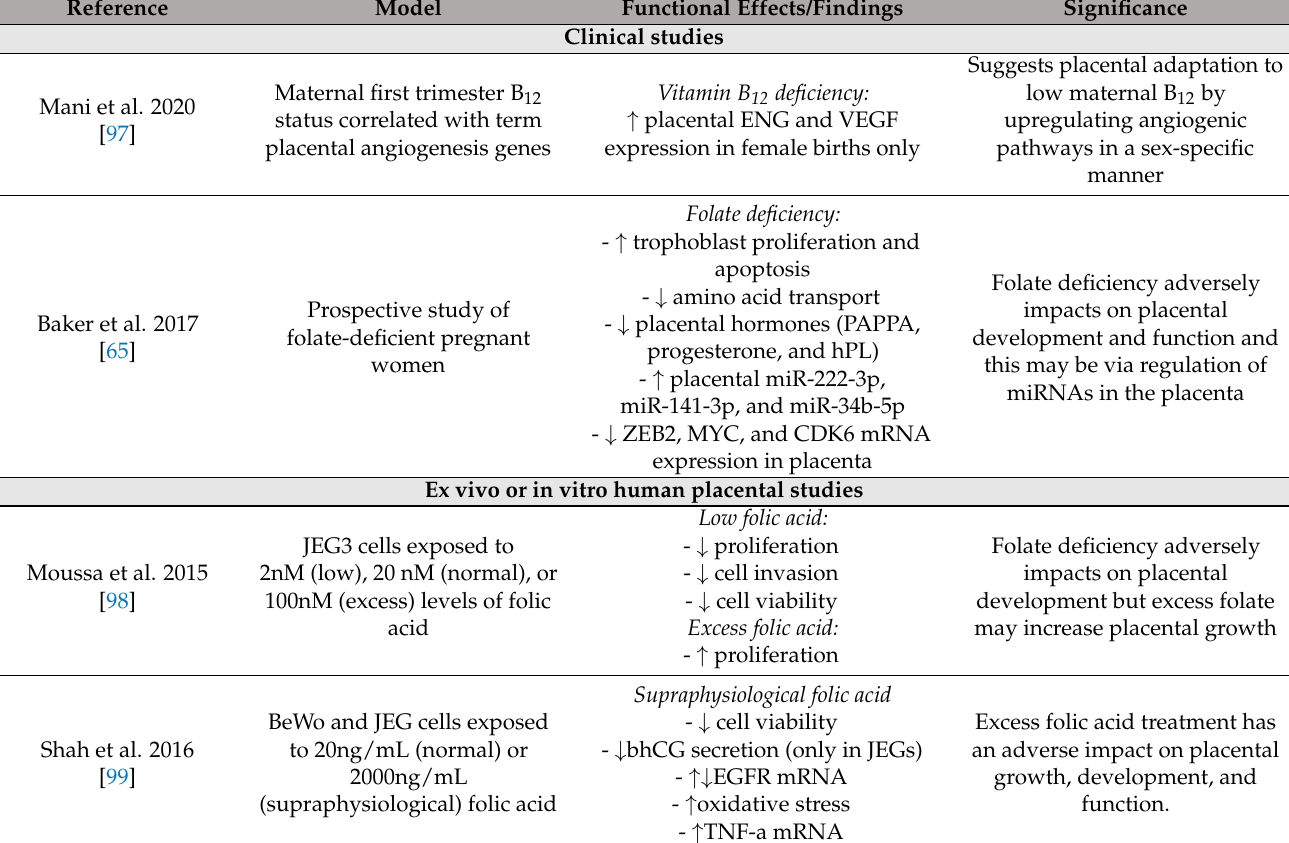
Table 2. Effects of folate and vitamin B 12 status on the placenta